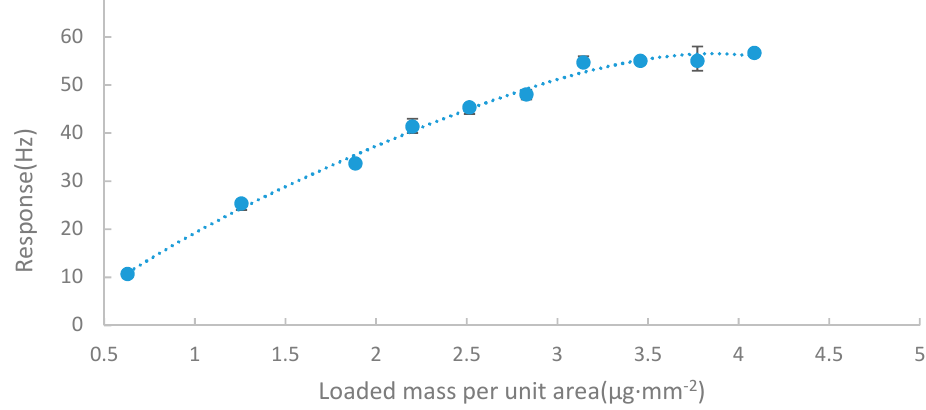
Figure 3. Response curve of the nano-Ni(OH) 2 QCM sensors to 24 ppb dibutyl phthalate (DBP) with different loaded mass of sensing material.